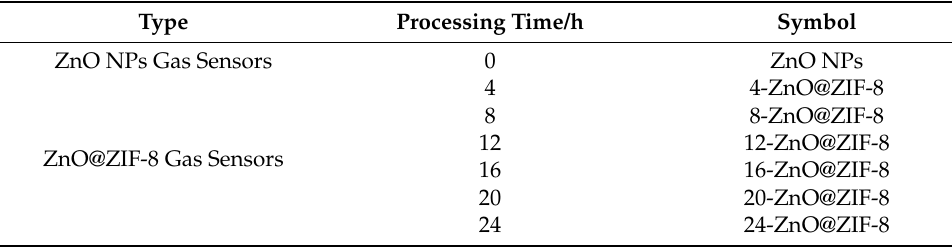
Figure 2. Schematic diagram of hydrothermal synthesis. Table 1. Symbols of the gas sensors.